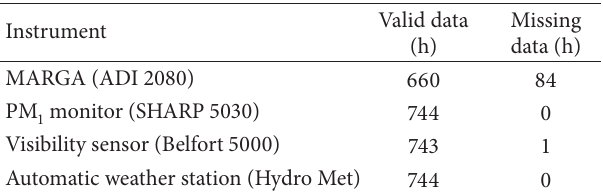
Table 1: Recoveries of the instruments during the measurement